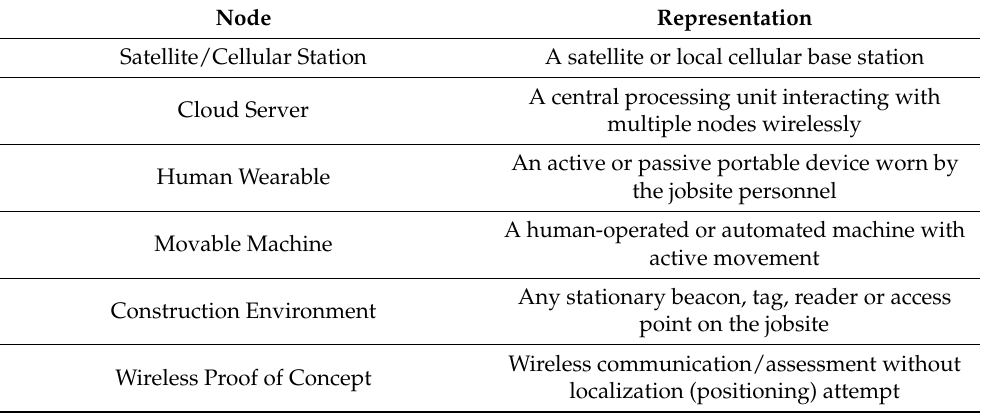
Table 2. Simplified node definitions for the novel communication